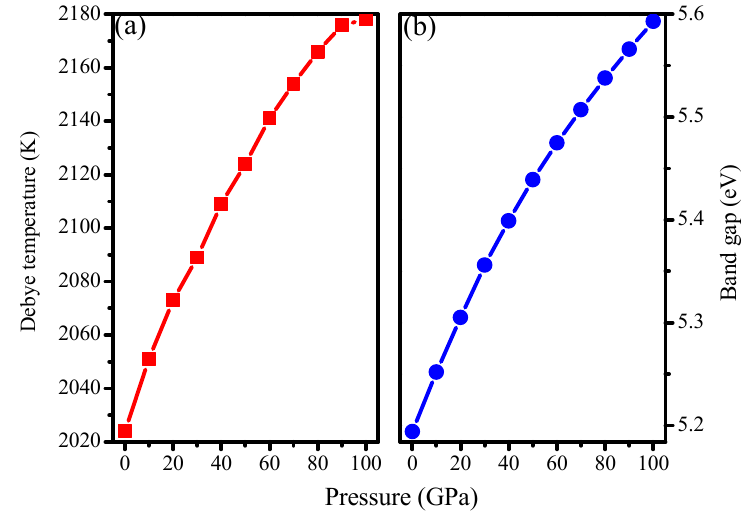
Figure 4. Debye temperature ( a ) and band gap ( b ) of 4 I –carbon as a function of pressure. Table 3. The calculated density ( ρ , in g/cm 3 ), the longitudinal, transverse, and mean elastic wave velocity ( v s , v p , v m , in m/s), and the Debye temperature ( Θ D , in K) for 4 I –carbon.